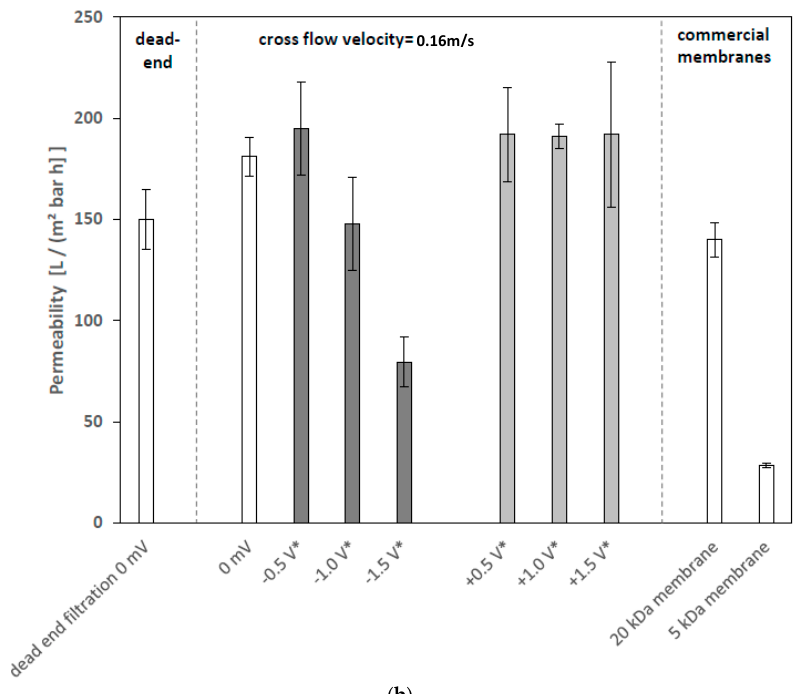
Figure 5. UV 254 rejection rates and permeability data; all experiments are conducted at least in triplicates with membrane surface of 42 cm 2 , transmembrane pressure (TMP) of 1 bar, cross-flow velocity of 0.16 m s − 1 (except of dead-end experiment), sample for rejection calculation is taken after filtration of 250 mL, feed: 6 mg L − 1 of SRNOM, 1 mmol L − 1 NaCl, pH 7; ( a ) rejection data after 250 mL of filtration; ( b ) permeability data after 250 mL of filtration, * all potentials are measured vs. Ag/AgCl reference electrode, error bars present standard deviations.